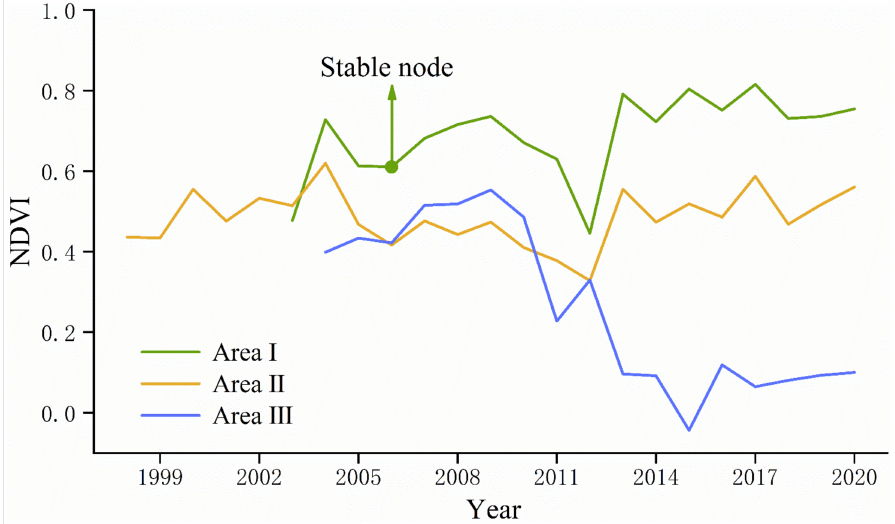
Figure 10. Annual average of NDVI in the “typical area” (area I) and the “problem areas” (areas II and